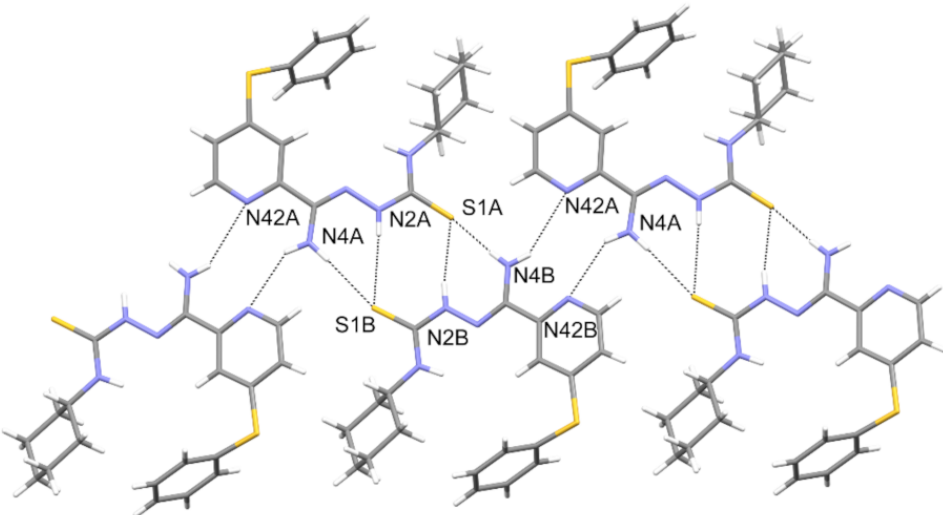
Figure 4. The intermolecular hydrogen bonds in compound 1 .